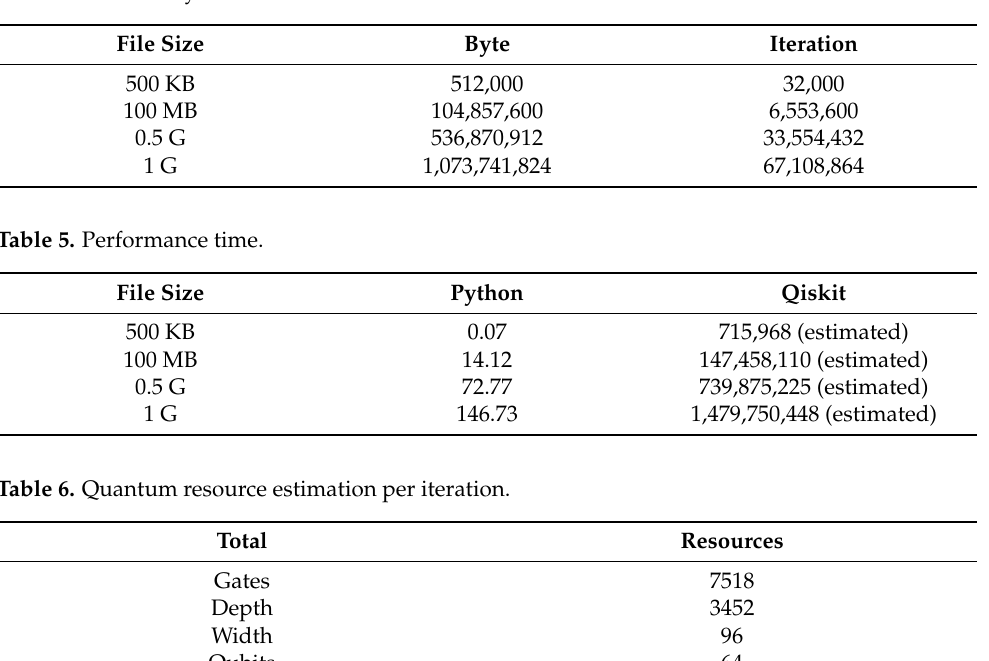
Table 4. Iteration by file size.